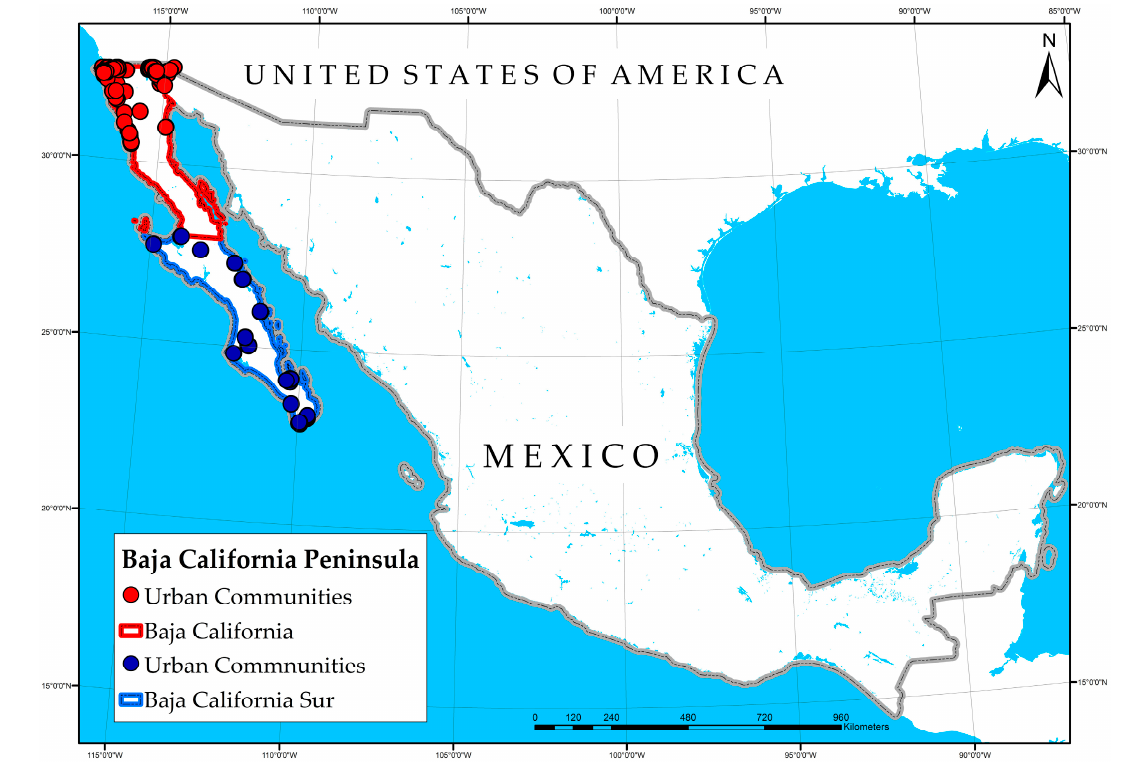
Figure 1. Baja California Peninsula.